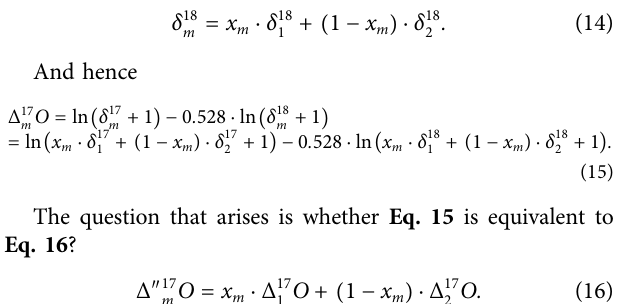
Figure 3 values corresponds to a combination of Eq. 17 for two cases, 1) for h (cid:1) 1 corresponding to the equilibrium fractionation only and 2) the common case of Eq. 17 . The balance value x corresponds here to: + x · α · α ( 1 − x ) · α eq kin eq